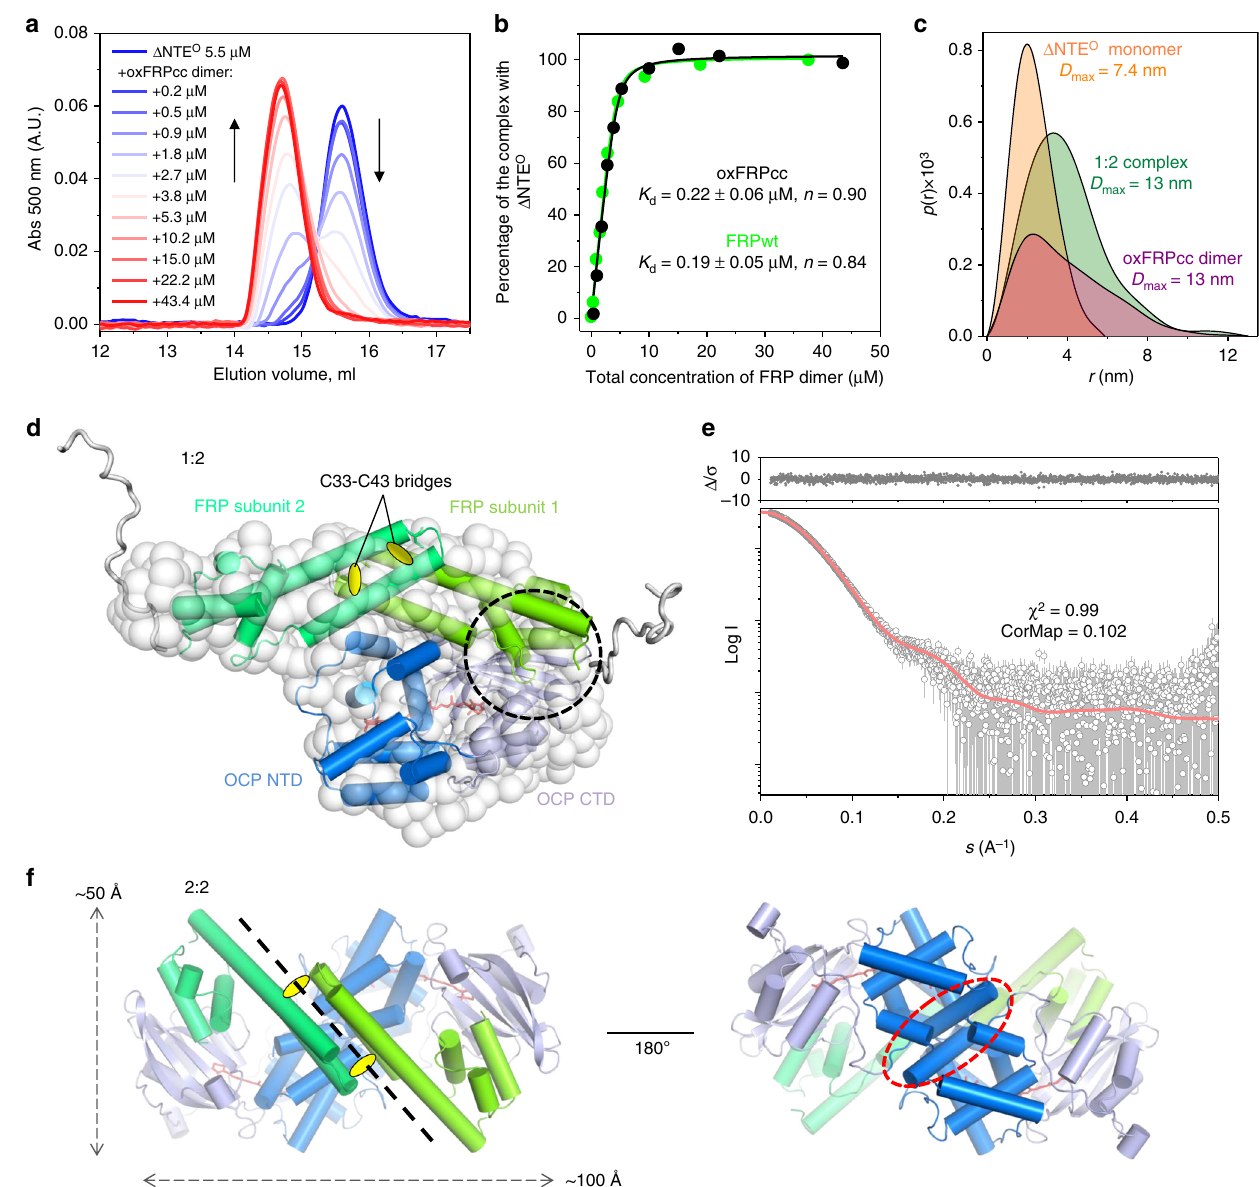
Fig. 5 Analysis of the Δ NTE O interaction with oxFRPcc. a A fi xed concentration of Δ NTE O was titrated by increasing amounts of oxFRPcc (indicated in µ M per dimer); the samples (100 µ l) were analyzed using a Superdex 200 Increase 10/300 column in the absence of reducing agents. Arrows indicate the direction of titration. b The binding curve obtained upon quanti fi cation of the amplitude of the Δ NTE O – oxFRPcc peak presented in a , in comparison with the curve for FRPwt (identical conditions). c Pairwise distance distribution functions for Δ NTE O , oxFRPcc dimer, and their complex obtained using GNOM. d One of the possible conformations of the Δ NTE O – oxFRPcc complex (1:2) consistent with the SAXS data and complementary information, shown as the CORAL-derived atomistic model overlaid with the best fi tting GASBOR-derived ab initio bead model. Dashed circle in d marks the tentative FRP binding site located on the β -sheet of the OCP-CTD, normally occupied by NTE in OCP O . e The fi t of the CORAL model to the SAXS data with the associated residuals ( Δ / σ ). f Hypothetical 2:2 binding on top of the 1:2 complex suggested by crosslinking experiments. Although two tentative OCP-binding sites on the head domains of FRP may coexist, the 2:2 binding leads to a clash between OCP molecules (marked by a red dashed circle). In the dissociable FRPwt, such a binding may provoke FRP monomerization and formation of the 1:1 heterocomplexes to relieve tension caused by the clashing OCP molecules. In oxFRPcc, this is not possible because of the covalent interface stabilization by disul fi